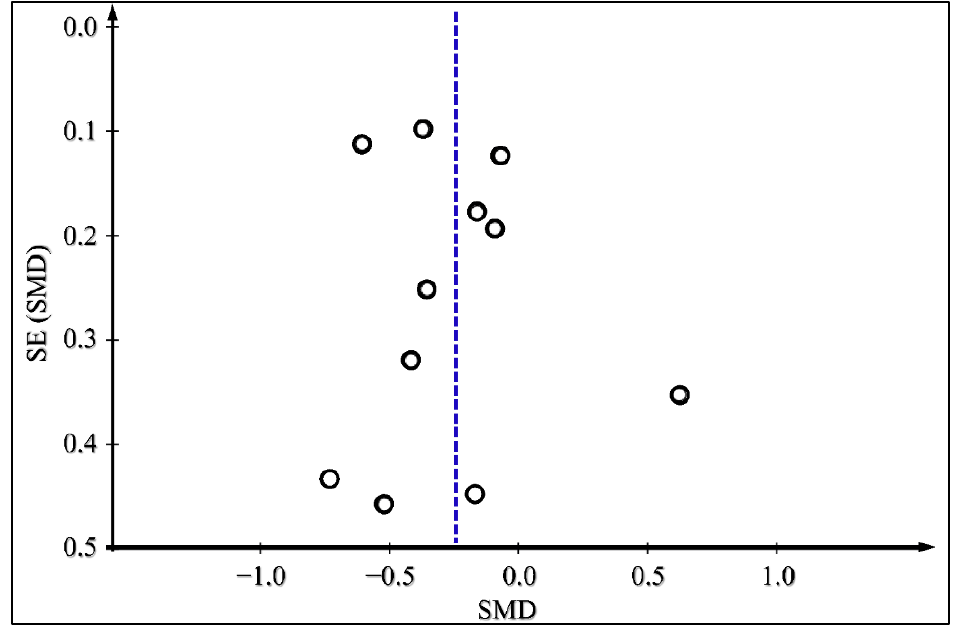
Figure 8. Funnel plot for Publication Bias Assessment for Glycated HbA1c.